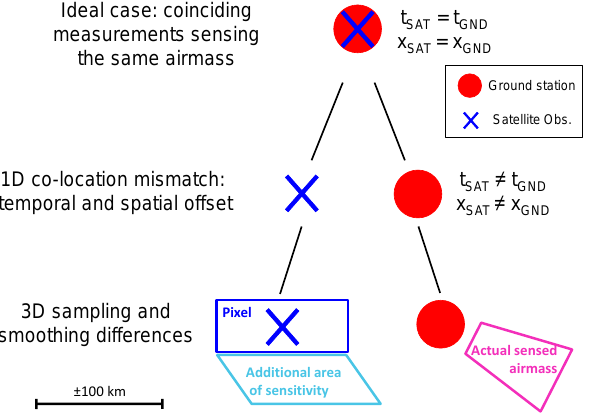
Figure 1. Conceptual visualization of the metrology of a satellite to ground measurement comparison. In the ideal case, ground and satellite-sensed air masses coincide in space and time. In practice, spatiotemporal sampling mismatches are inevitable, and the extent of the actually sensed air masses around the nominal locations de- pends on measurement types and atmospheric